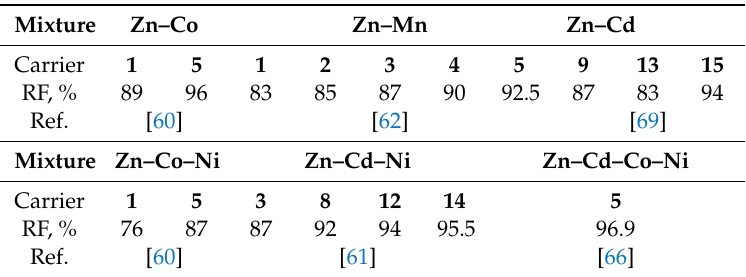
Table 13. The recovery factor (RF) of zinc during the transport of a mixture of ions across PIMs doped with alkylimidazoles after a 24-h